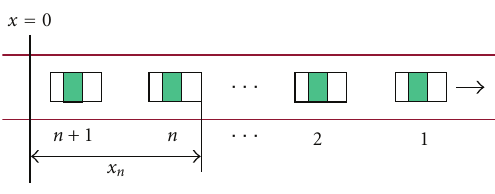
Figure 1: Car-following behavior.